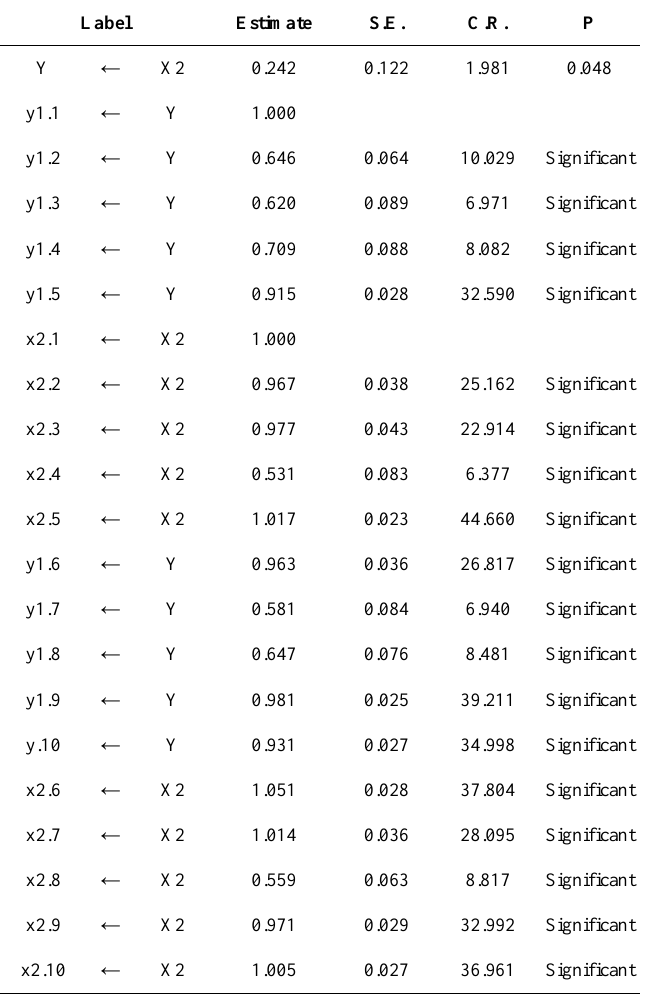
Table 4. Results of IV and CR Tests of Exogenous Variables of Business Motivation